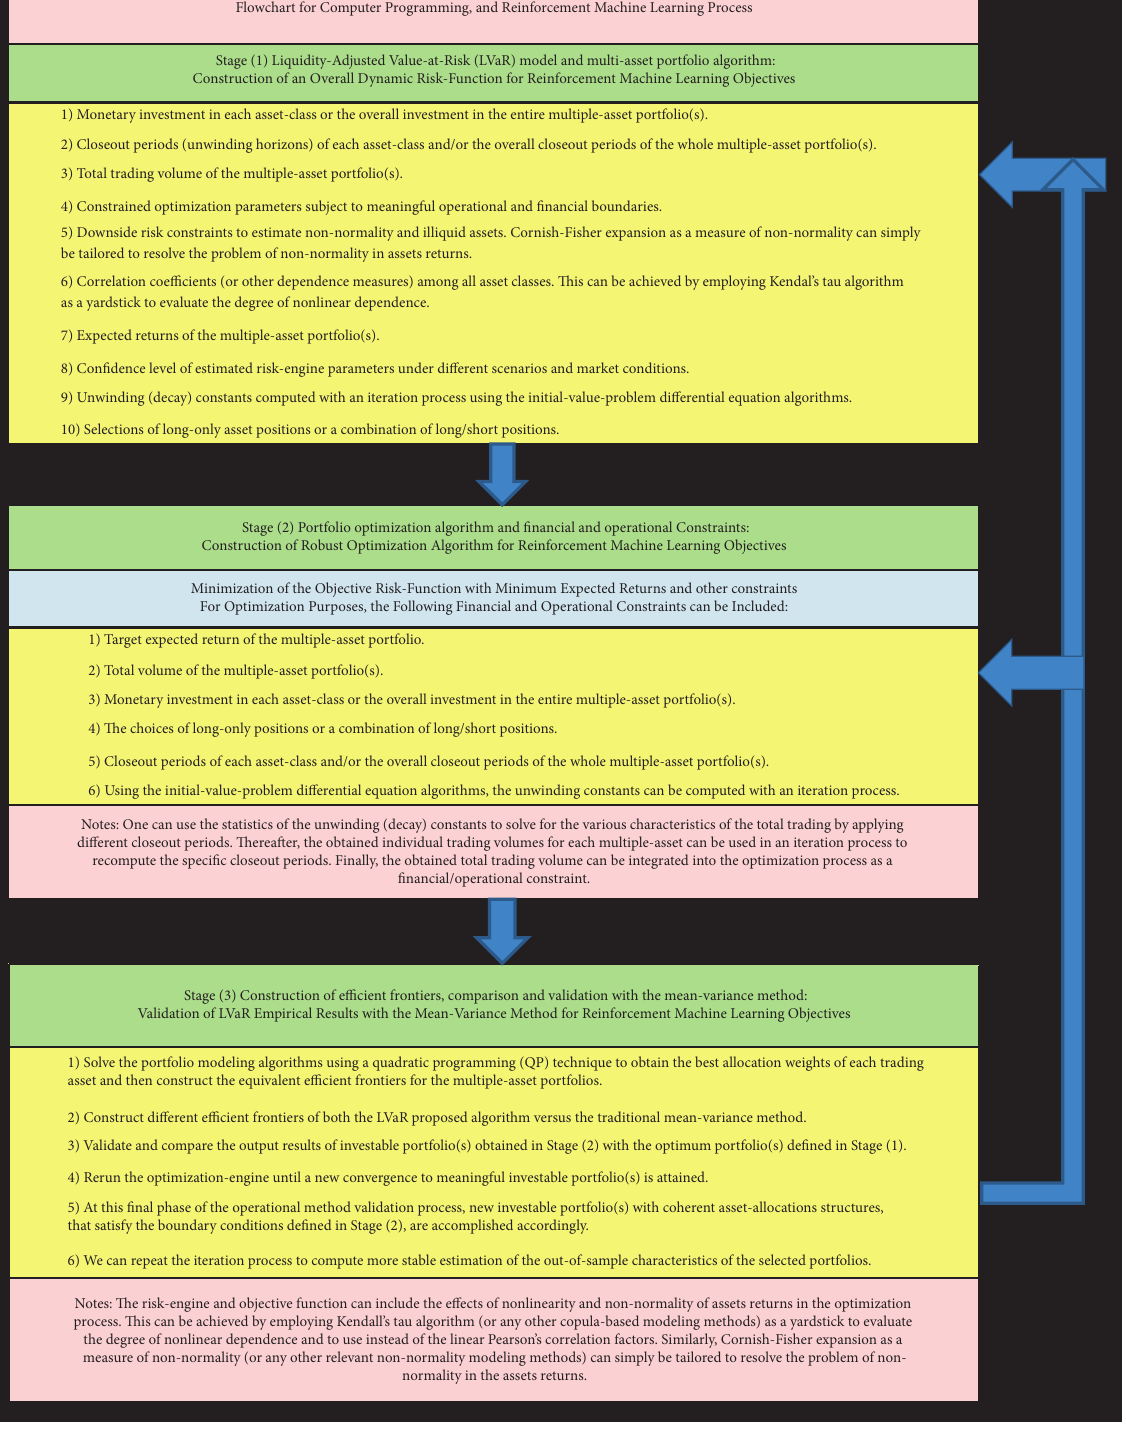
Figure 1: A graphical flowchart of the operational stages of the proposed modeling